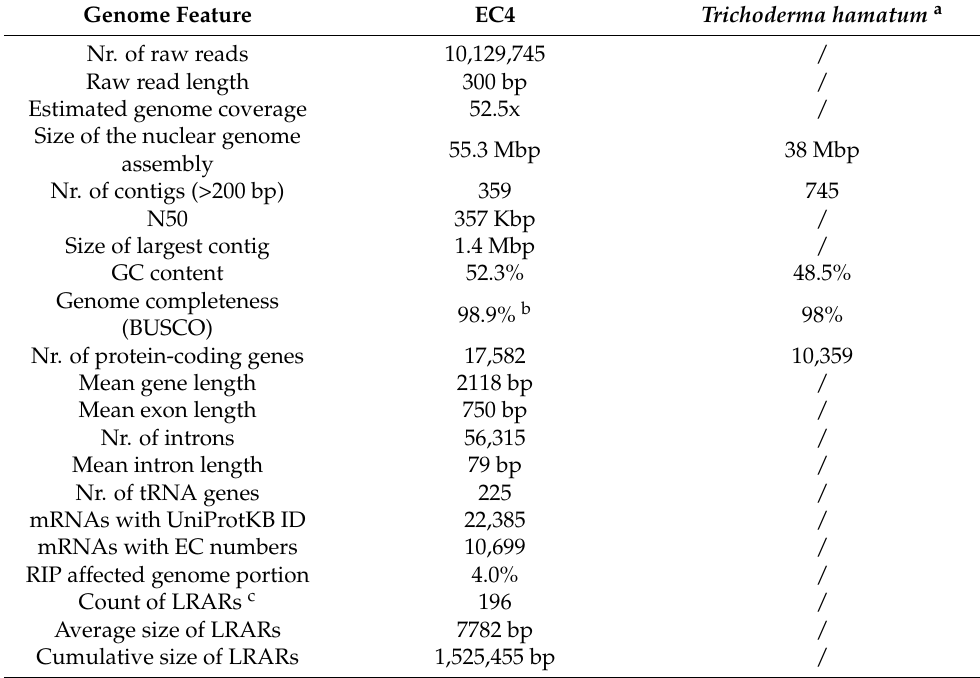
Table 1. Nuclear genome statistics of EC4 and Trichoderma